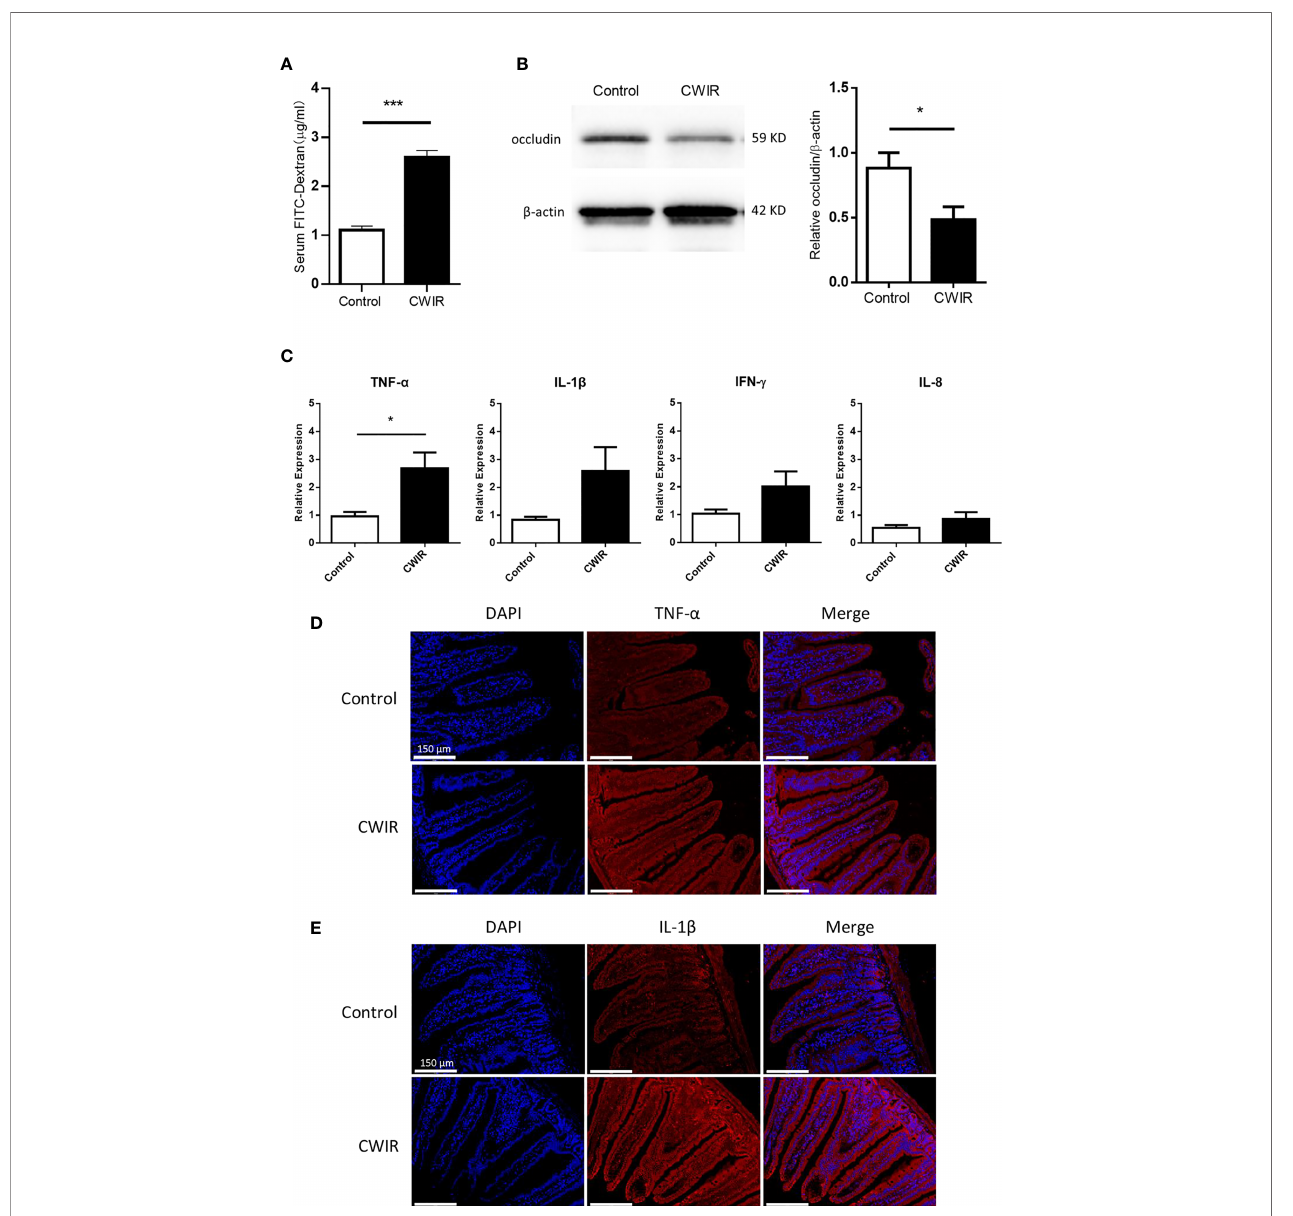
FIGURE 3 | Effect of CWIR on the intestinal barrier function. (A) gastrointestinal (GI) permeability barrier defect, as determined by fl uorescein isothiocyanate (FITC)-labeled dextran detection in CWIR injury mice or control mice. Leakage of FITC-dextran from the gut was measured (in serum) 2 h post oral administration. n = 10-11 mice per group, *** P < 0.001 vs . WT control, Student ’ s t -test was used to compare the values between the two groups. (B) Representative western blot image and protein quanti fi cation to detect occludin, a tight junction molecule, in the small intestine of CWIR injury mice or control mice. n = 5 per group, * P < 0.05 vs . WT control. (C) mRNA levels of proin fl ammatory cytokines in the small intestine. All data are shown as the mean ± SEM, Student ’ s t -test was used to compare the values between the two groups. * P < 0.05 vs . WT control, n = 4 – 6 per group. (D) Representative anti-TNF- a immuno fl uorescent photomicrographs of the duodenum. TNF- a -speci fi c antibodies were detected using Cy3-conjugated secondary antibodies (red), n = 3 per group; Scale bar = 150 m m. (E) Representative photomicrographs of immuno fl uorescence against IL-1 b of the duodenum. IL-1 b -speci fi c antibodies were detected using Cy3-conjugated secondary antibodies (red), n = 3 per group; Scale bar = 150 m m. Nuclei were counterstained with